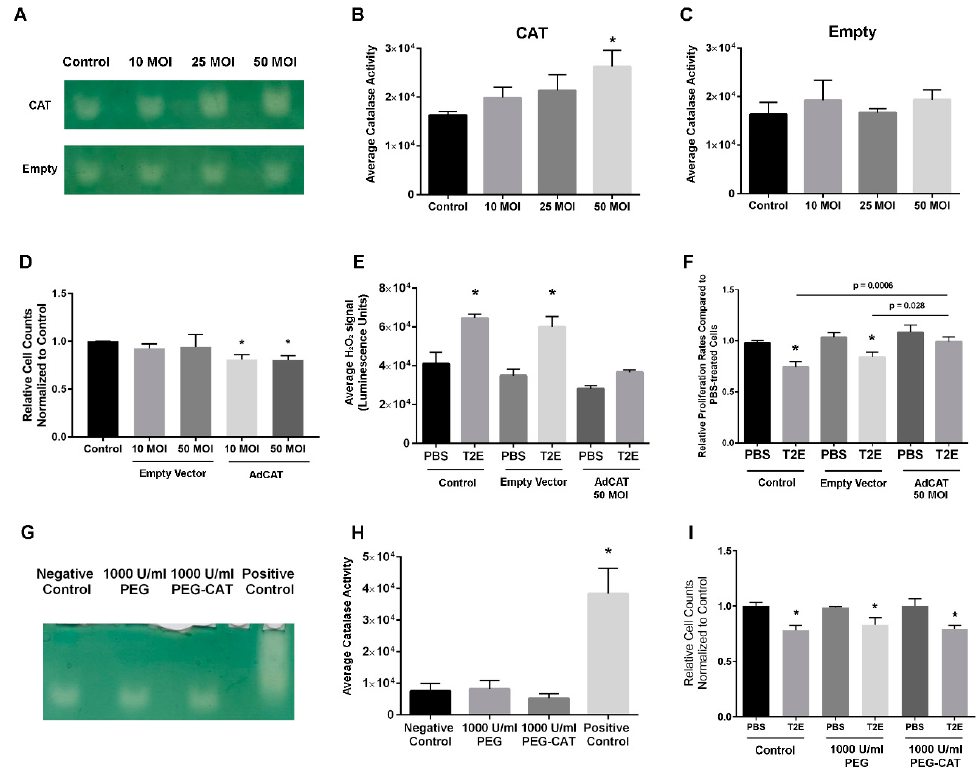
Figure 2. The e ff ects of MnTE-2-PyP-induced intracellular H 2 O 2 increase on PC3 cell proliferation. ( A ) A representative image of catalase activity in PC3 cells with di ff erent MOI catalase adenovirus (CAT) / empty vector (Empty) transduction. ( B , C ) Densitometry analysis of ( A ). ( D ) Relative PC3 cell counts with adenovirus transduction after 96 h. ( E ) Measurement of cellular H 2 O 2 levels and ( F ) relative PC3 cell counts with 50 MOI catalase adenovirus / empty vector transduced after 96 h treatment of PBS or MnTE-2-PyP. ( G ) Cellular catalase activity of PC3 cells treated with PEG-catalase (1000 U / mL) or PEG (corresponding amount of 1000 U / mL PEG-catalase) for 24 h. ( H ) Densitometry analysis of ( G ). ( I ) Relative cell counts of PC3 cells after 96 h treatment of PBS or MnTE-2-PyP with PEG or PEG-catalase. All data represent mean ± SD from at least three independent experiments. * p < 0.05 compared to PBS treatment.